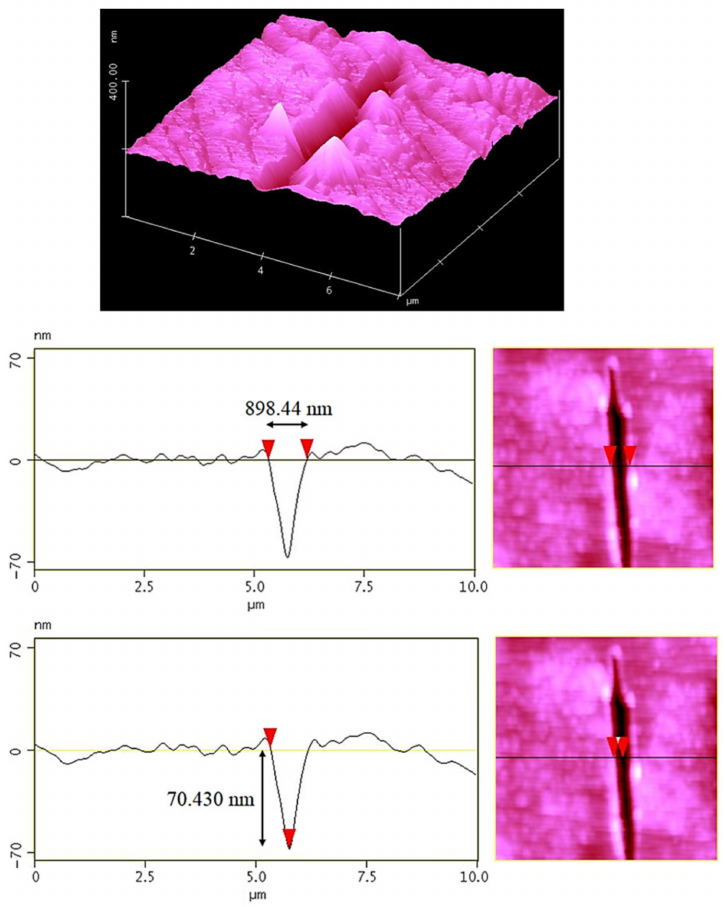
Figure 10. AFM image of a scratch from an Fe 3 Al sample and its associated cross